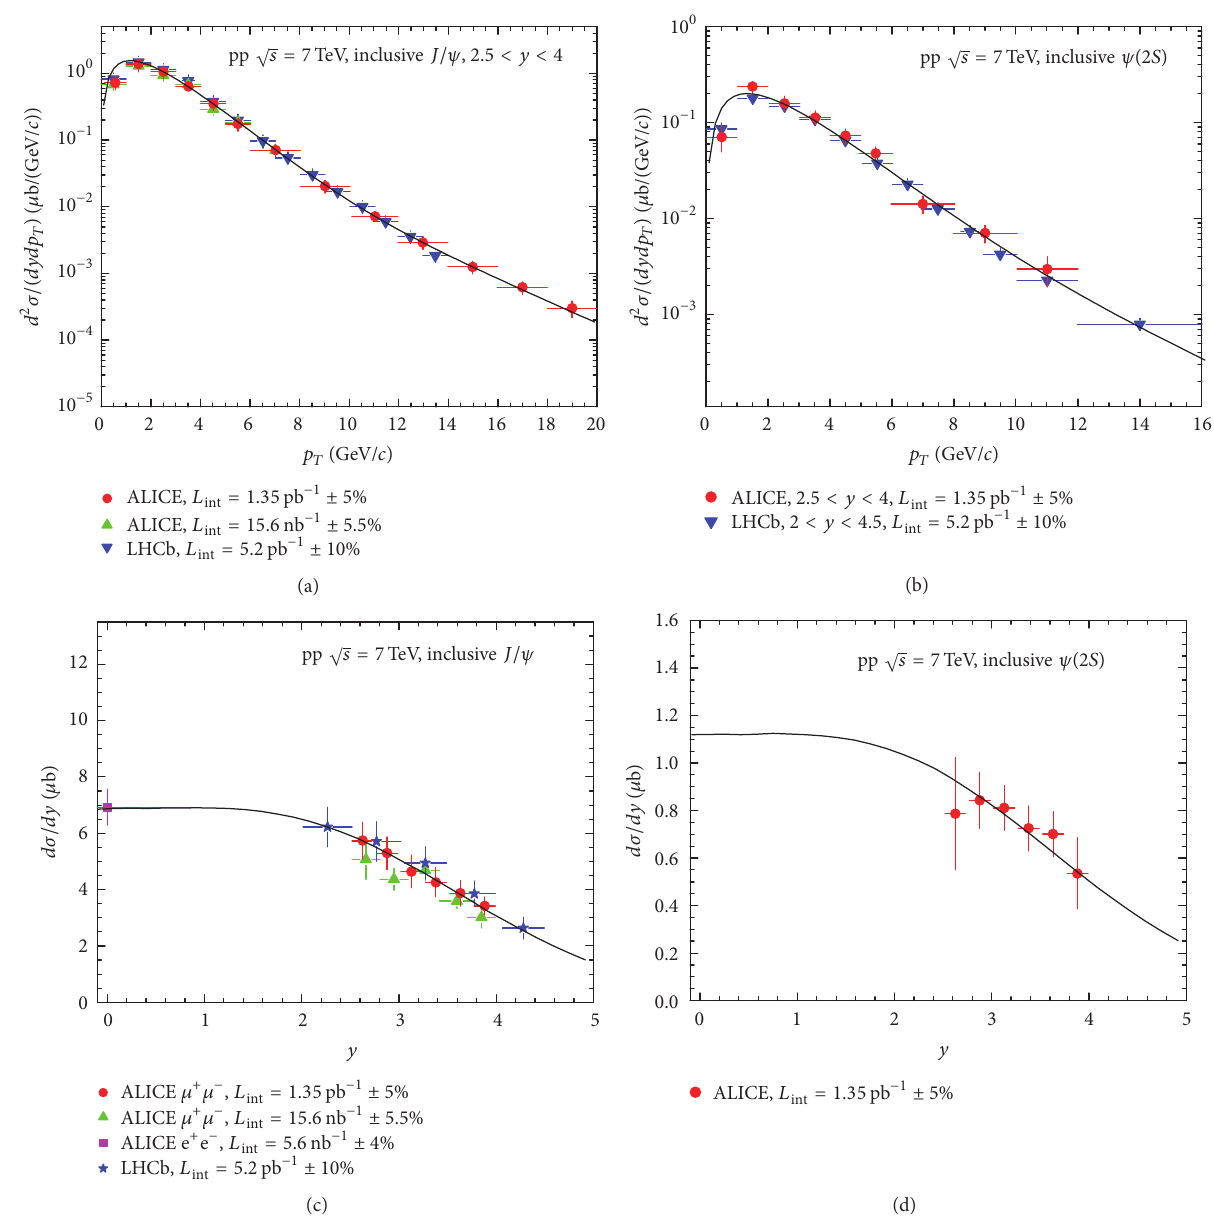
Figure 5: (a)-(b) Transverse momentum spectra and (c)-(d) rapidity spectra of (a)-(c) inclusive 𝐽/𝜓 mesons and (b)-(d) inclusive 𝜓(2𝑆) mesons produced in pp collisions at √𝑠 = 7 TeV. The closed symbols represent the experimental data of the ALICE [30–32] and LHCb Collaboration [33, 34] in different conditions shown in the panels, and the error bars are only the statistical uncertainties. The curves are our results calculated by using the hybrid